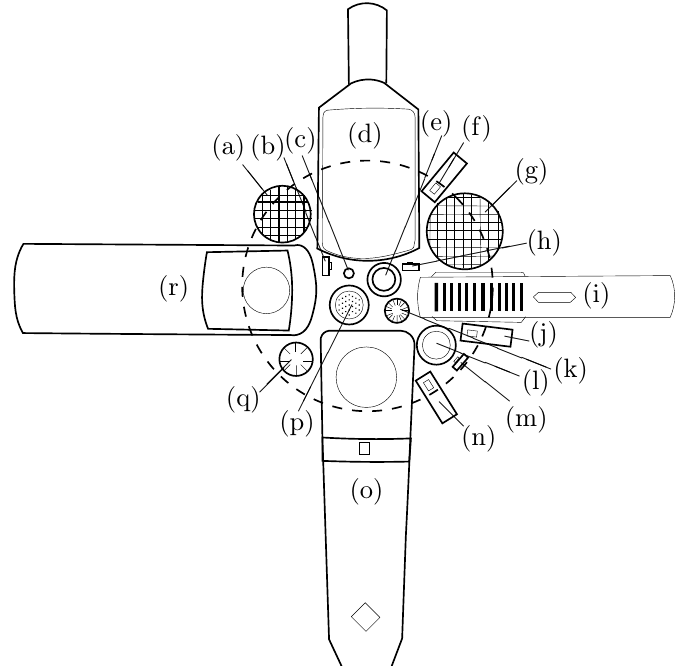
Figure 5. Validation microphone array. (a) AKG C1000S; (b) Cirrus WM7331 (side on); (c) Country- Figure 7.1: Validation array layout. (a) AKG C1000S; (b) Cirrus WM7331 (side on); (c) man B3; (d) AKG D12; (e) Schoeps CMC6U with 2H capsule; (f) Cirrus WM7331 (face on); (g) Sony Countryman B3; (d) AKG D12; (e) Schoeps CMC6U with 2H capsule; (f) Cirrus WM7331 F730; (h) Cirrus WM7132 (side on); (i) Royer R-121; (j) Cirrus WM7132 (face on); (k) Sony ECM670; (l) (face on); (g) Sony F730; (h) Cirrus WM7132 (side on); (i) Royer R-121; (j) Cirrus WM7132 Hebden HS3000 (omni); (m) WM7138 (side on); (n) WM7138 (face on); (o) Neumann U87 (cardioid); (p) Hebden HS3000 (hyper-cardioid); (q) DPA 4015; (r) Sony